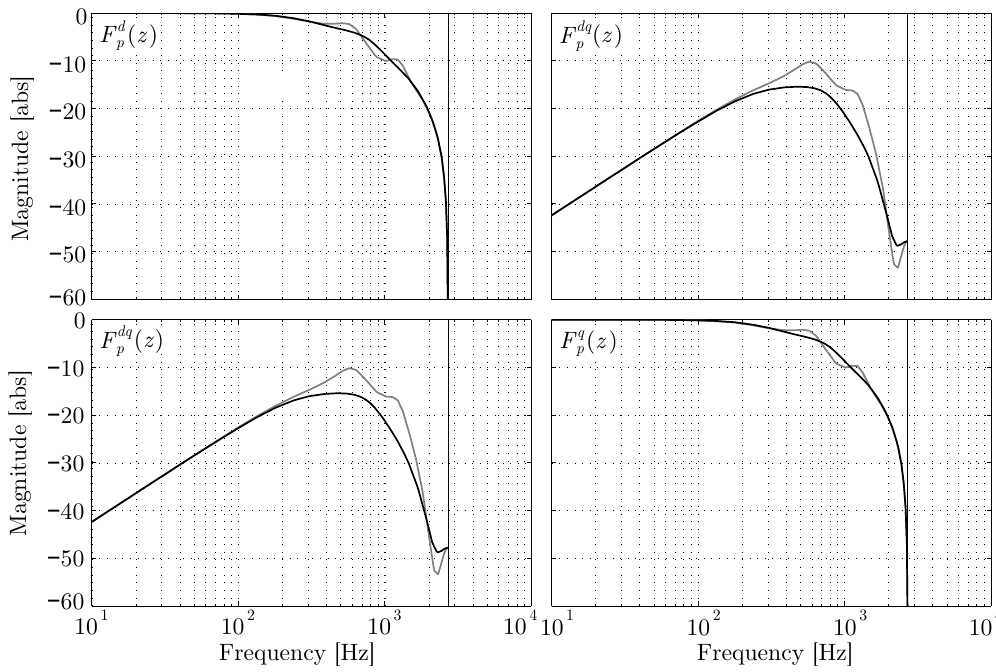
Figure 10. Bode plot of F d p ( z ) , F q p ( z ) , F dq p ( z ) , and F qd p ( z ) , (black) with predictions and (grey) without predictions.